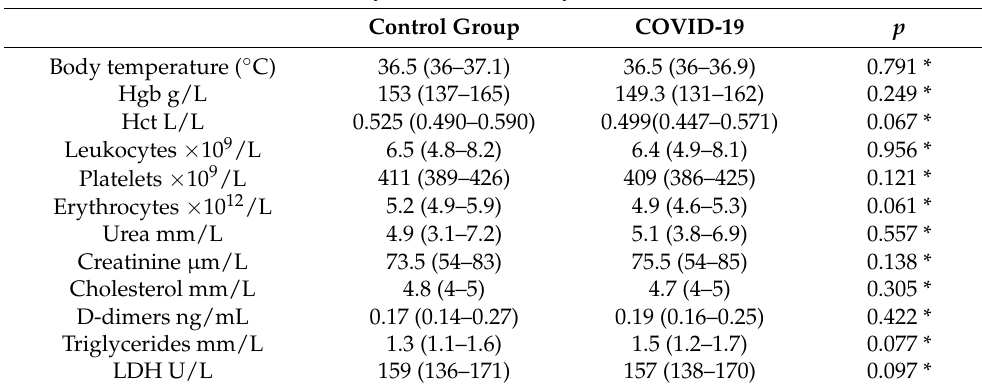
Table 5. Quantitative laboratory variables of subjects after COVID-19 infection and control group 300 days after